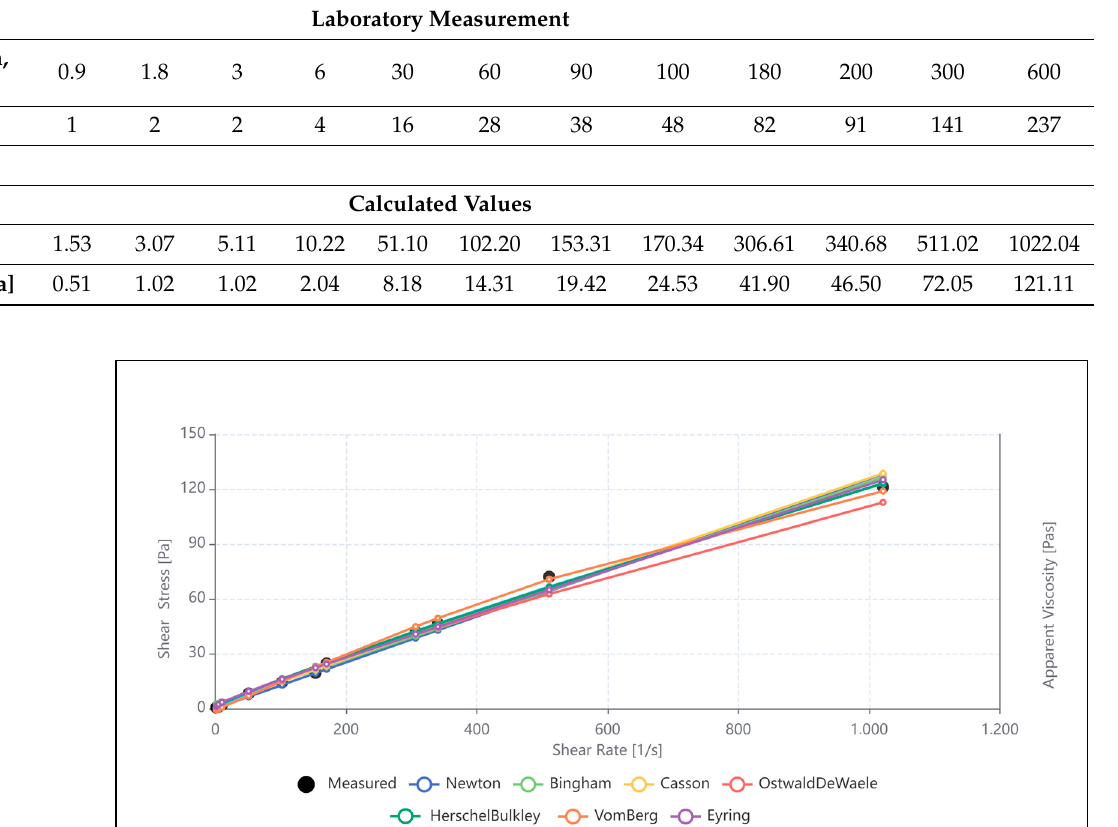
Table 1. Results of laboratory measurements and calculations of shear stresses and shear rates for cement slurry tested on a 12 speed Fann viscometer 35A/SR-12, with the arrangement of cylinders R1-B1 and spring F1 [15].